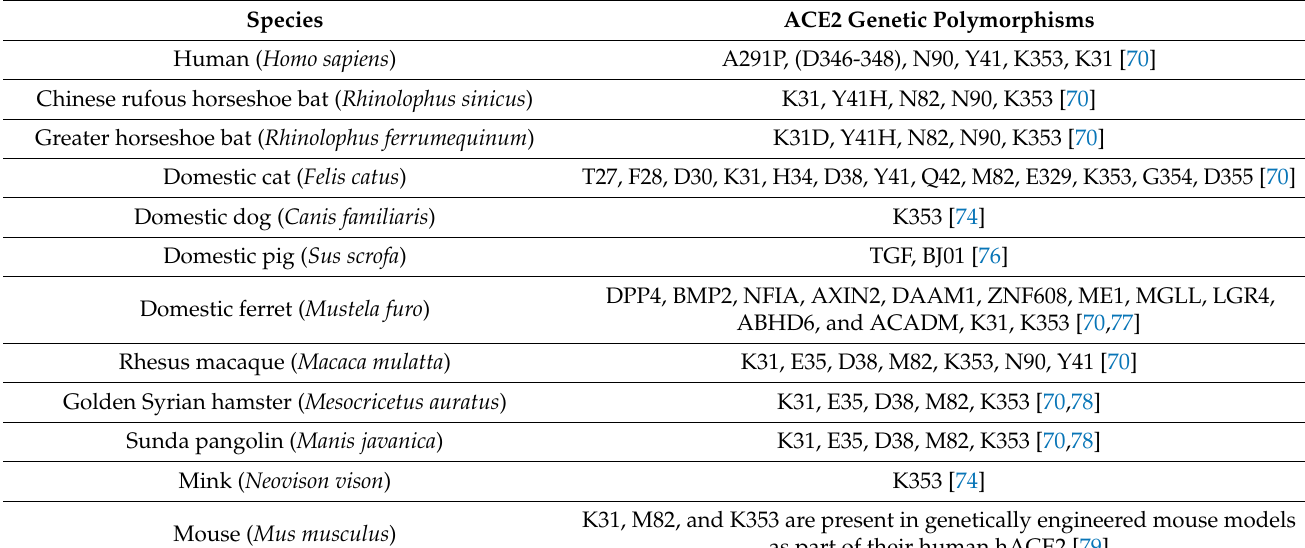
Table 1. Comparison of genetic polymorphisms of the ACE2 receptor in twelve mammalian species: Human ( Homo sapiens ), Chinese rufous horseshoe bat ( Rhinolophus sinicus ), greater horseshoe bat ( Rhinolophus ferrumequinum ), domestic cat ( Felis catus ), domestic dog ( Canis familiaris ), domestic pig ( Sus scrofa ), domestic ferret ( Mustela furo ), rhesus macaque ( Macaca mulatta), golden Syrian hamsters ( Mesocricetus auratus ), Sunda pangolin ( Manis javanica ), mink ( Neovison vison ), and mouse ( Mus musculus ). Of note, the polymorphisms K31, Y41, N90, and K353 correlate with increased susceptibility of the species to COVID-19